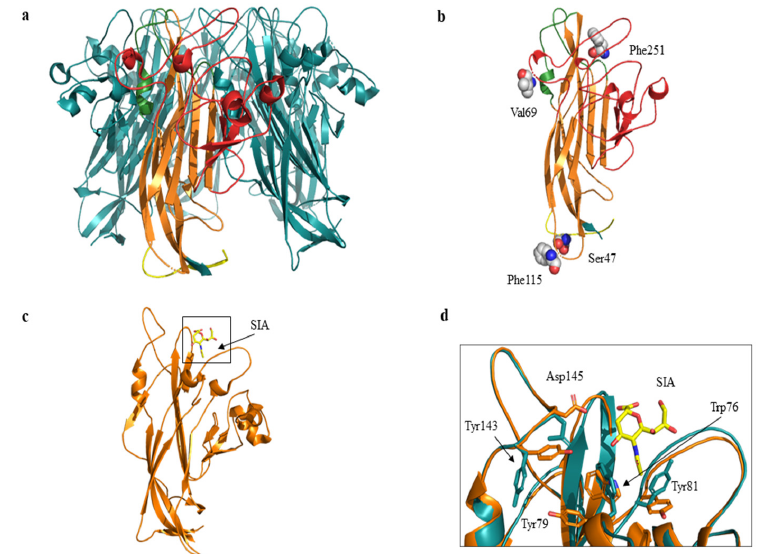
Figure 5. Cartoon and three-dimensional model of MCPyV VP1 pentamer and monomer. ( a ) VP1 pentamer. The monomer is highlighted in yellow (N-term region), in orange ( β sandwich core), in green (apical or membrane binding loops) and in red (side or neutralizing epitope loops). The C-term region is not shown. ( b ) Three-dimensional model of VP1 monomer. Residues corresponding to the mutated sites are displayed as spheres and labelled. 7 P revealed Val69 and Phe251 substitutions, 7 U and 17 U revealed Ser47 and Phe115 substitutions respectively. ( c ) VP1 monomer shown as cartoon representation. The sialic acid (SIA) binding site is highlighted in the black box. SIA is displayed in yellow sticks. ( d ) Superposition between wild-type (orange) and ModRefiner monomer (cyan) models. Residues located in proximity of sialic acid (SIA) are displayed as sticks and labelled. Tyr79 corresponds to the mutated